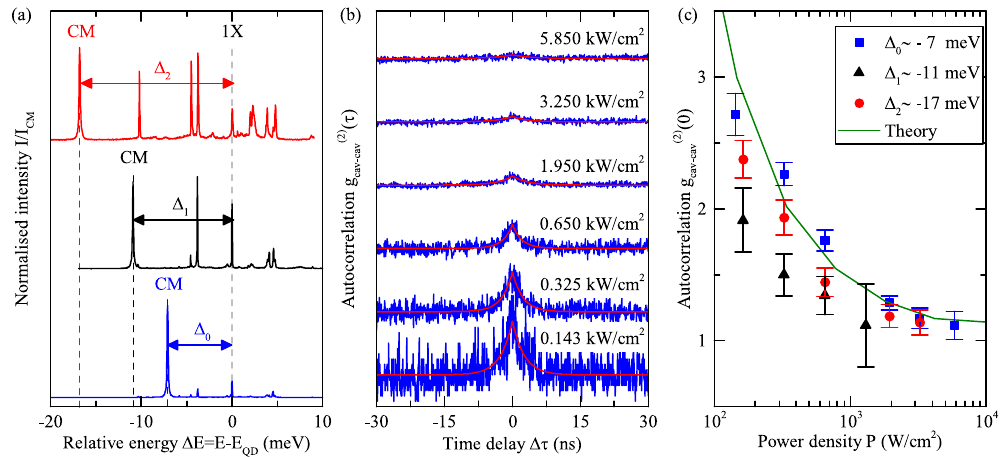
Figure 2. ( a ) Photoluminescence spectra for three different QD-CM detunings ∆ − ~ 7 ∆ − ~ 11 meV (black) and ∆ = − 17 meV (red). ( b ) Auto-correlation measurements of the cavity mode at 1 2 E CM for ∆ 0 and excitation powers corresponding to spectra shown in Fig. 1(a) (lower panel). Solid lines are fits to the data. ( c ) Second oder correlation g (0) (2) as function of the excitation power density for ∆ (black) and ∆ (red). The solid green line has been obtained from the microscopic 2